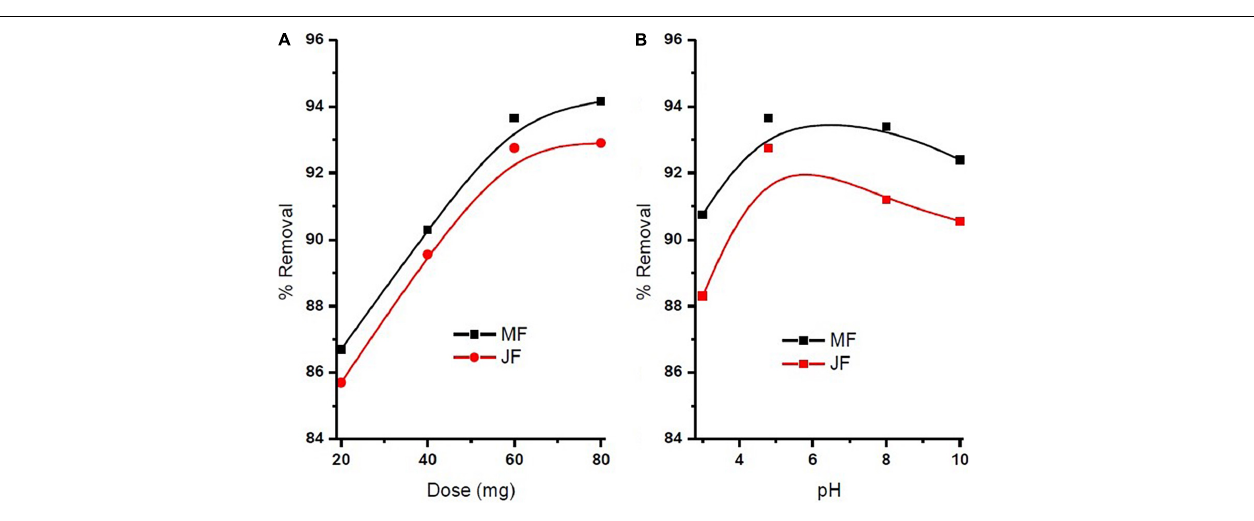
FIGURE 8 | (A) Influence of seeds bio sorbent dosage on chromium % removal and (B) influence of solution pH on chromium % removal (contact time = 80 min, pH = 4.8, initial concentration = 2.5 mg · L − 1 , agitation speed = 400 rpm, room temperature).